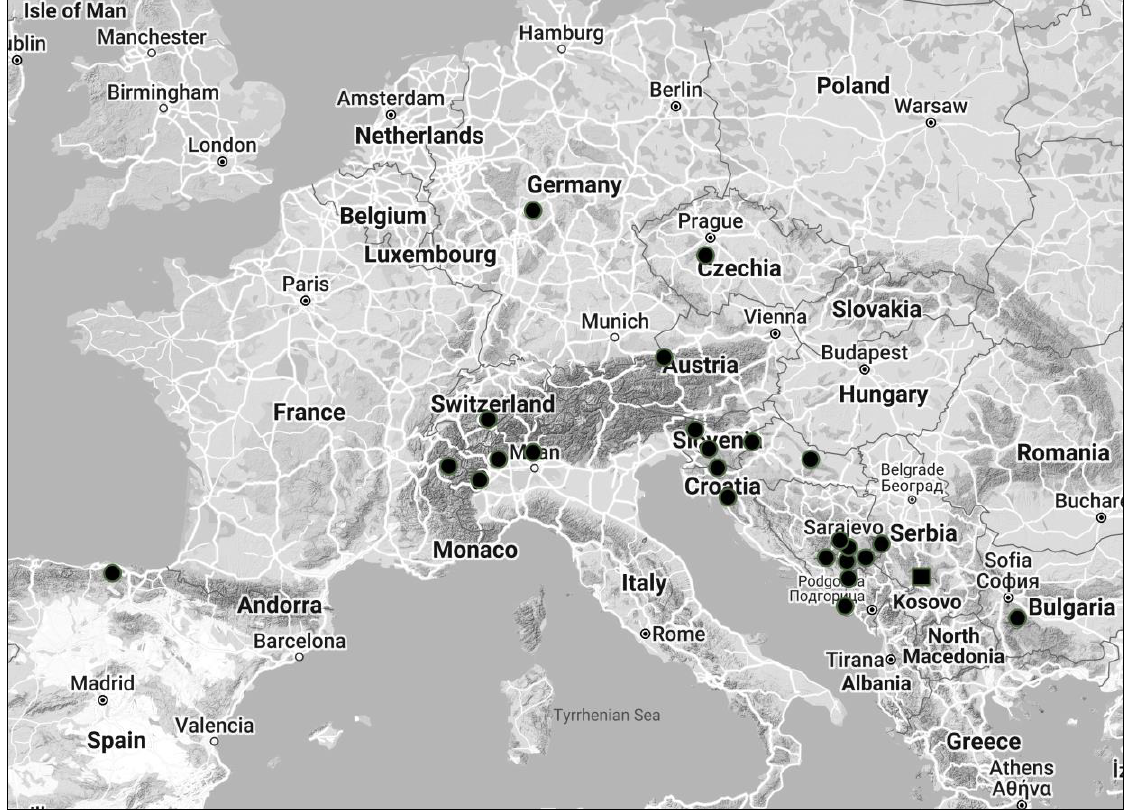
Figure 3. Distributiоn of Lumbricus meliboeus in Europe (circles − literature data (seen M ILUTINOVIĆ et al ., 2013); square − new